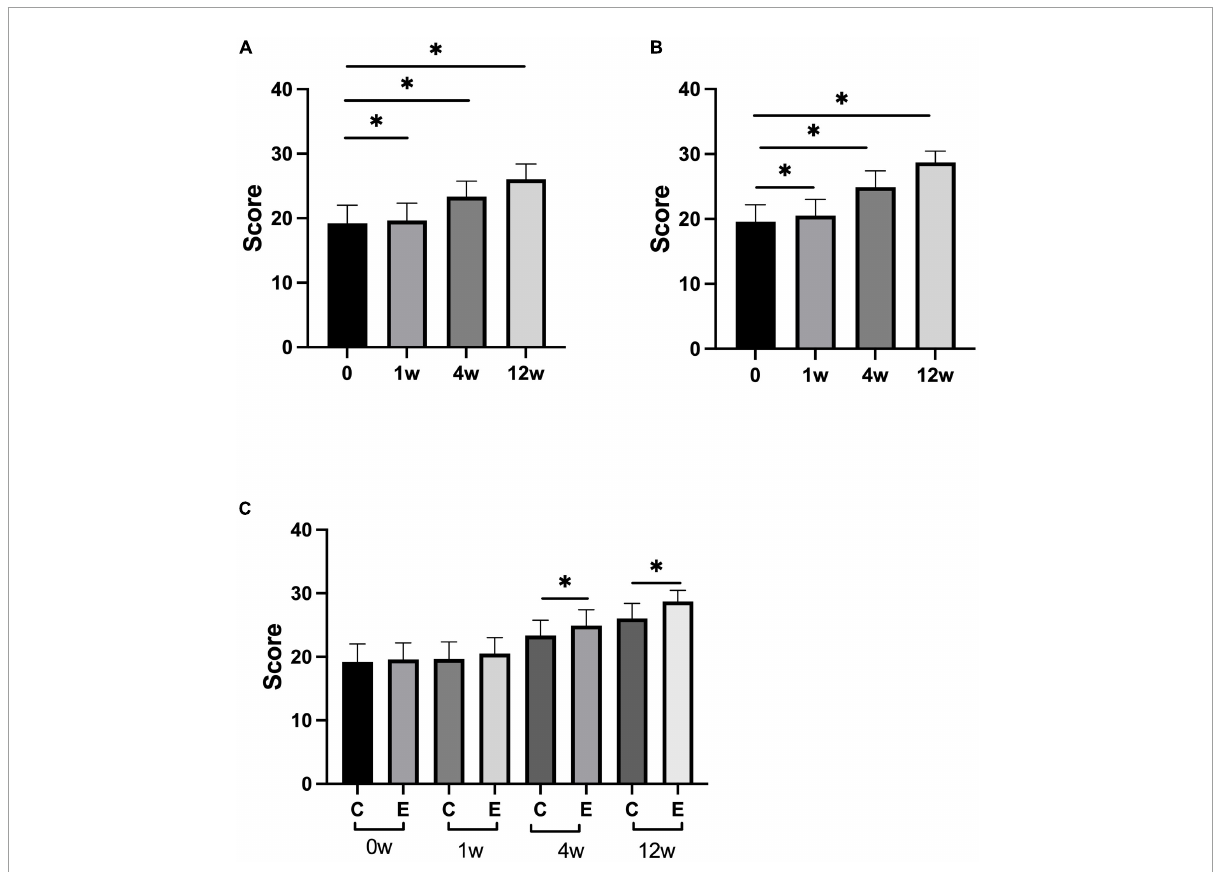
FIGURE3 Changes in lower-limb Fugl–Meyer assessment (L-FMA) scores. (A) Scores of L-FMA at 1, 4, 12 weeks compared with that at 0 week in control group; (B) scores of L-FMA at 1, 4, 12 weeks compared with that at 0 week in experimental group; (C) scores of L-FMA at 0, 1, 4, and 12 weeks in experimental group compared with control group; ∗ p <